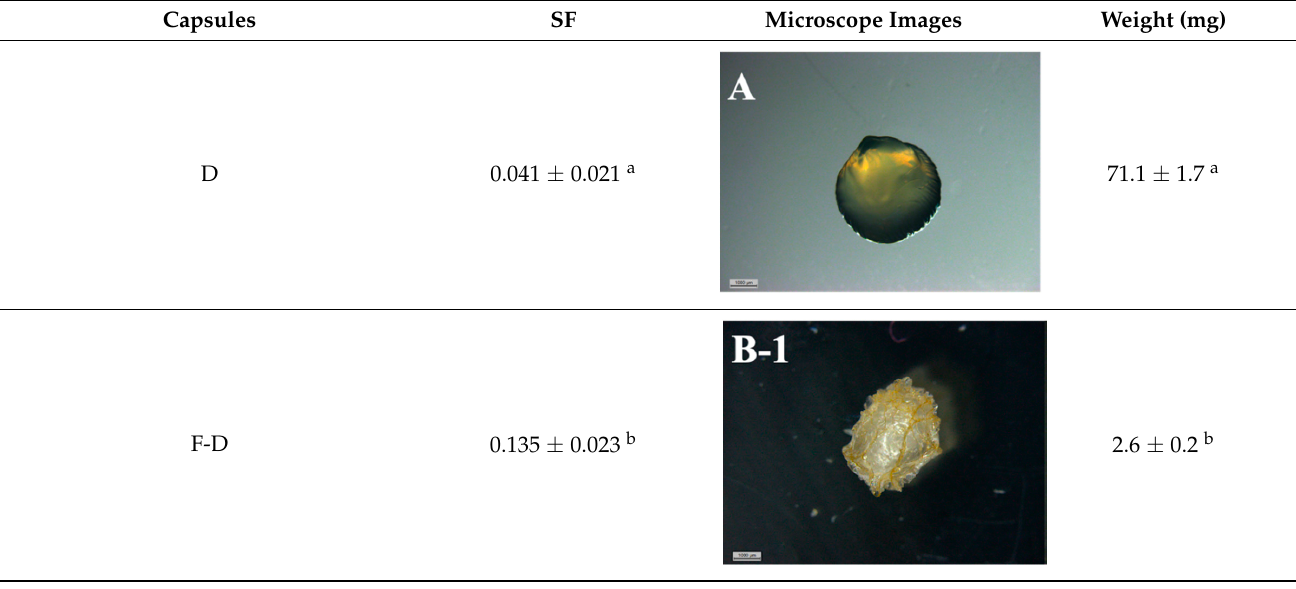
Table 4. Sphericity factor values (SF), stereo microscope images (all with a magnification of 12 × ) and weight (mg) of the capsules. D (microscope images A) refers to freshly made capsules, F-D (microscope images B1-5) to freeze-dried capsules, and T-D ((microscope images C1-5) to thermal-dried capsules. Different letters indicate significant differences ( p < 0.05).